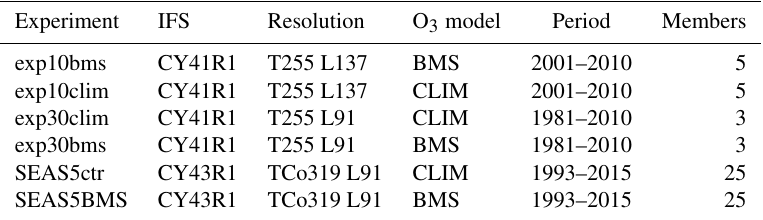
Figure 1. Monthly averaged time series of the vertical profiles of ozone (mPa) over southern high latitudes (55–90 ◦ S) for the period August 2012–August 2013. Panels show ozone concentrations as measured by ozone sondes (a) , as simulated with the new ozone scheme in IFS (b) and as simulated with the default IFS scheme (c) . The vertical distribution and the time evolution of the ozone hole and its recovery are better represented by the new scheme. Table 2. Seasonal experiments using the new ozone scheme (BMS) or the default ozone configuration in which the radiation sees an ozone climatology (CLIM). For each experiment information on model version, resolution, period covered and the number of ensemble members is also